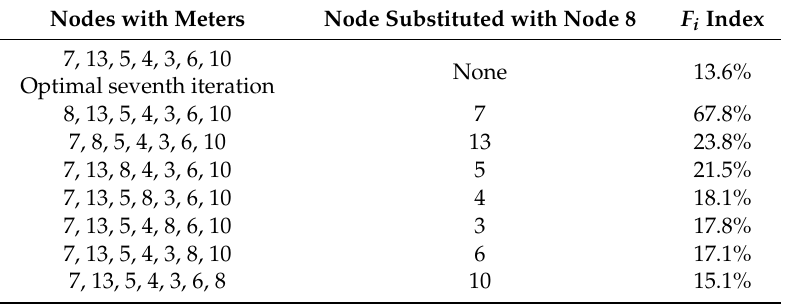
Figure 12. Branch power flow uncertainties obtained when one PM is added to node 8 and one PM is removed from the seven-meter optimal condition found for the Vittorio Emanuele feeder. Table 6. Sensitivity index when one PM is added to node 8 and one PM is removed from the seven-meter optimal condition found for the Vittorio Emanuele feeder.